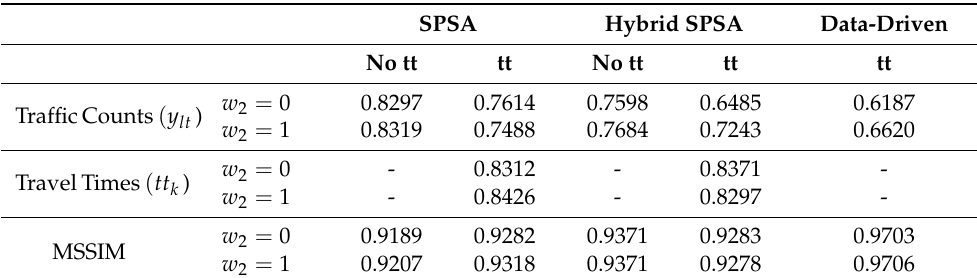
Figure 6. Traffic count and travel time linear regressions when w 2 = 1. Table 1. R 2 adjustments and MSSIM between